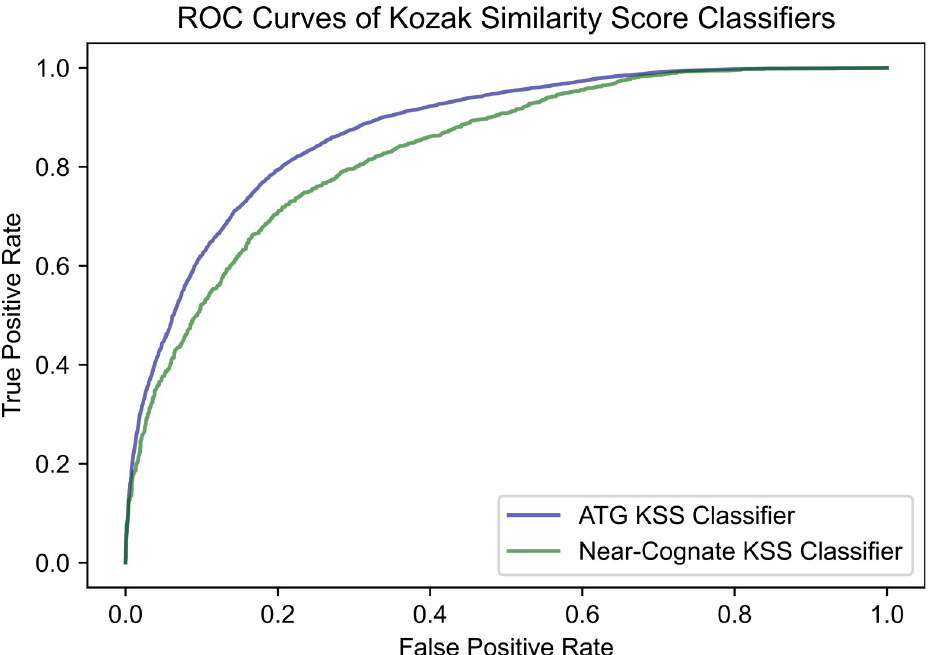
Fig 5. ROC curves of the ATG and near-cognate Kozak similarity score classifiers. The AUROC score (area under the curve) of the ATG classifier is 0.876. The AUROC score of the near-cognate RFC is 0.835.